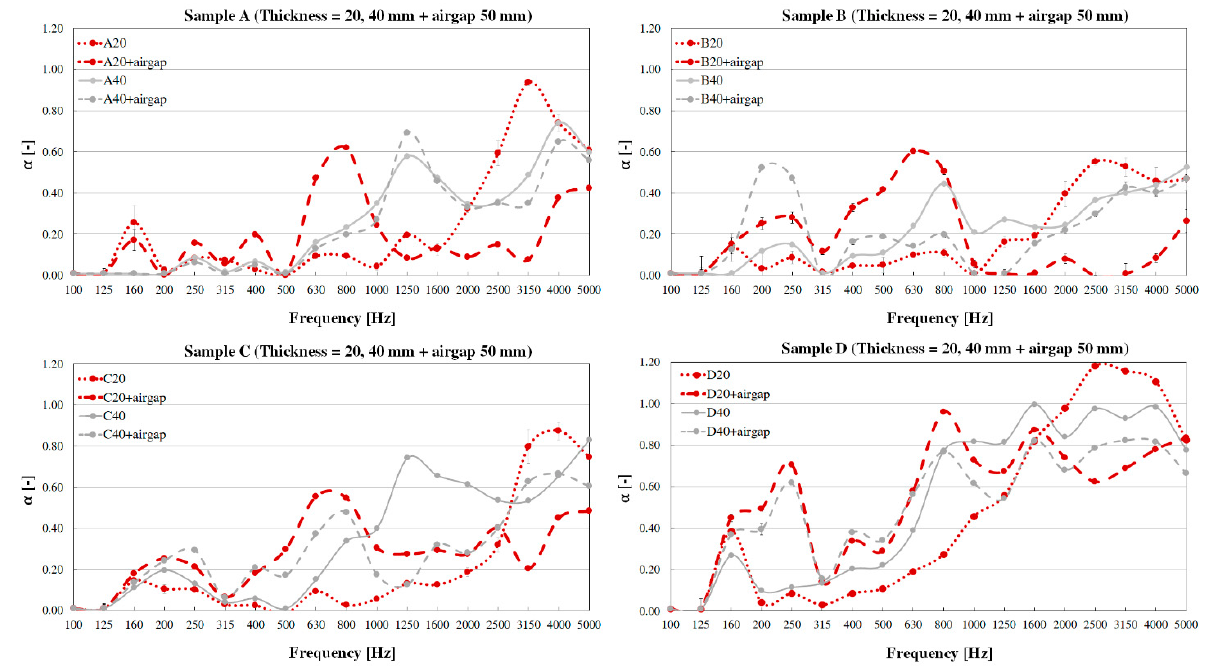
Figure 7. Comparison of the absorption coefficients for samples ( A – D ) of different thicknesses (20 and 40 mm) mounted with an air gap of 50 mm. Sample ( A ): crushed aggregates 4–8 mm; Sample ( B ): round lightweight aggregates 4–8 mm; Sample ( C ): round lightweight aggregates 2–4 mm; Sample ( D ): round lightweight aggregates 0.5–1 mm.